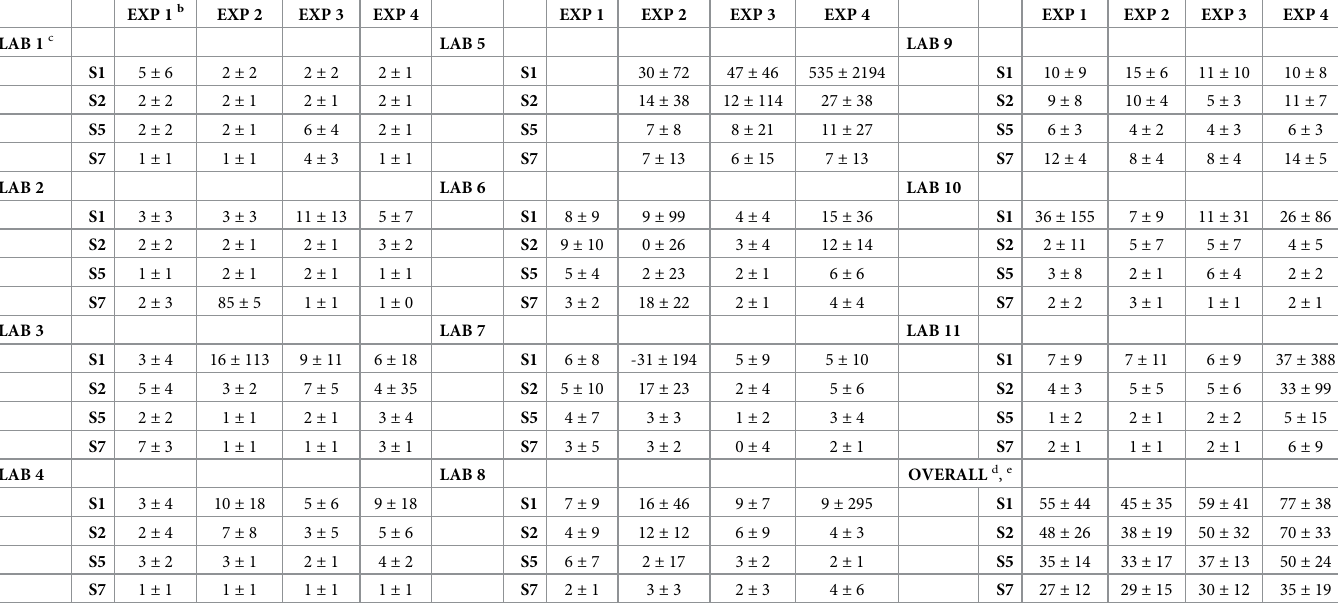
Table 6. Average coefficient of variation across bead sets a